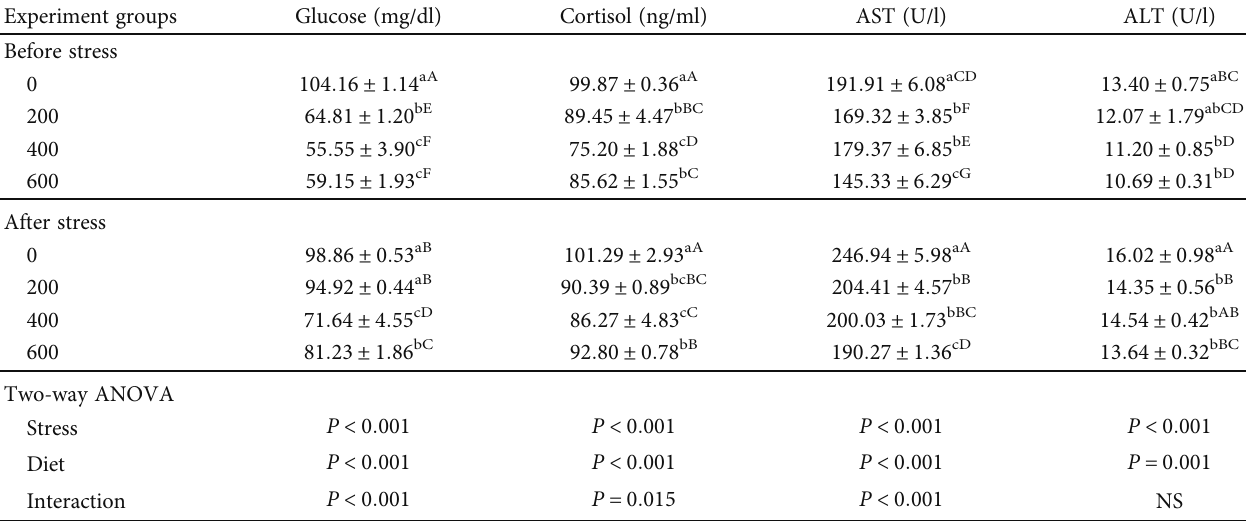
Table 6: Stress factors of common carp fed di ff erent levels of quercetin for 60 days before and after heat stress. Experiment